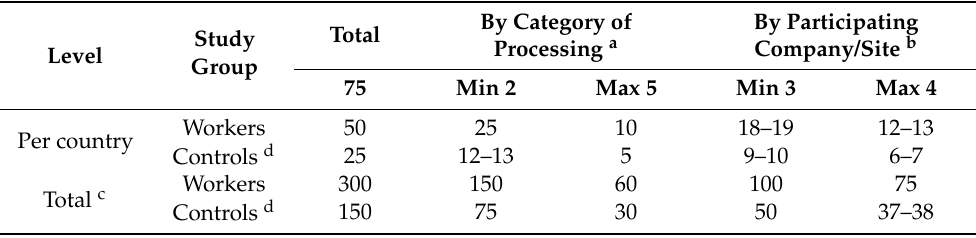
Table 7. Target number of workers and controls to be recruited in total, by category and by partici- pating